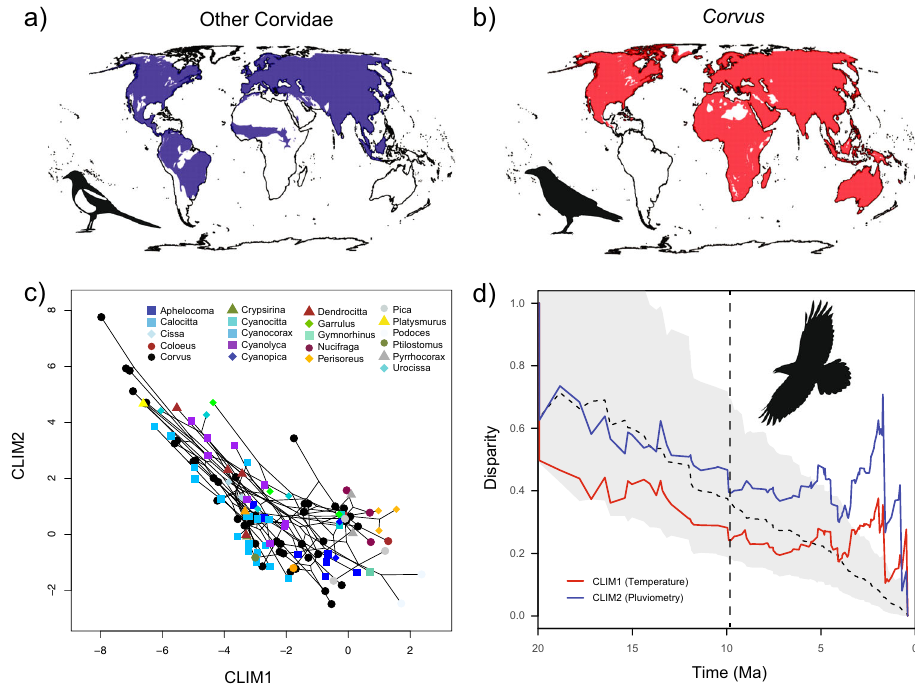
Fig. 5 Distributions and climatic niche of Corvus and Corvidae. World distributions of a all species of Corvidae excluding Corvus and b all species of Corvus . c Climatic space occupied the family Corvidae. Black lines depict phylogenetic relationships among species. d DTT for climatic diversi fi cation in the family Corvidae. The vertical dashed line indicates the onset of diversi fi cation of the genus Corvus . Grey shaded areas depict 95% credible intervals for DTT estimated in